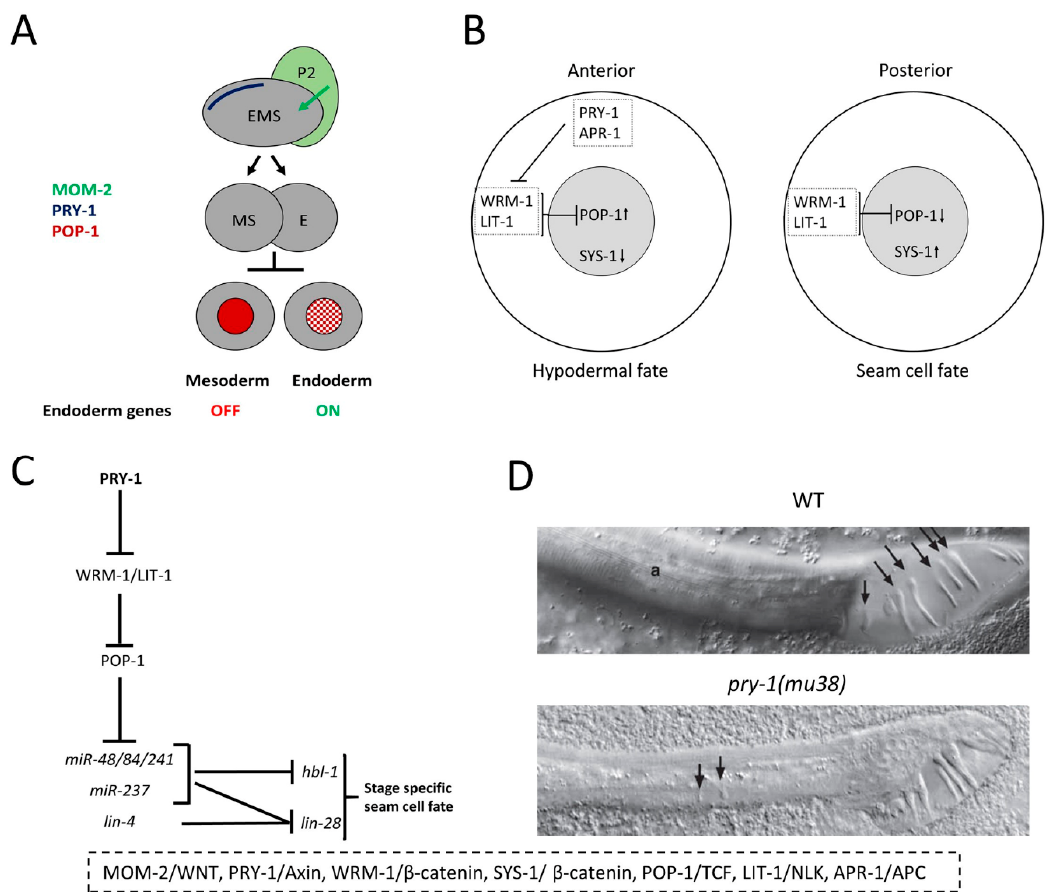
Figure 6. PRY-1 negatively regulates asymmetric cell division during C. elegans development. ( A ) Model for EMS division. PRY-1, located in the anterior cortex of EMS during asymmetric division, is involved in conferring endodermal and mesodermal fates of daughter cells. ( B ) Similar to EMS division, a model for seam cell division. PRY-1 negatively regulates WNT signaling in the anterior cell, which ultimately adopts a hypodermal fate. ( C ) A genetic pathway consisting of PRY-1-mediated regulation of heterochronic miRNAs and their targets during seam cell development. ( D ) pry-1(mu38) males show defective tail morphology. In wild-type (WT) animals, rays are located in the fan-like region (marked by arrows in the upper panel). In pry-1 mutants, alae have been replaced with ectopic rays (arrows in the lower panel). The vertebrate homologs of C. elegans genes are listed on the bottom. Panels B and C adopted with permission from [66] and panel D from [148].